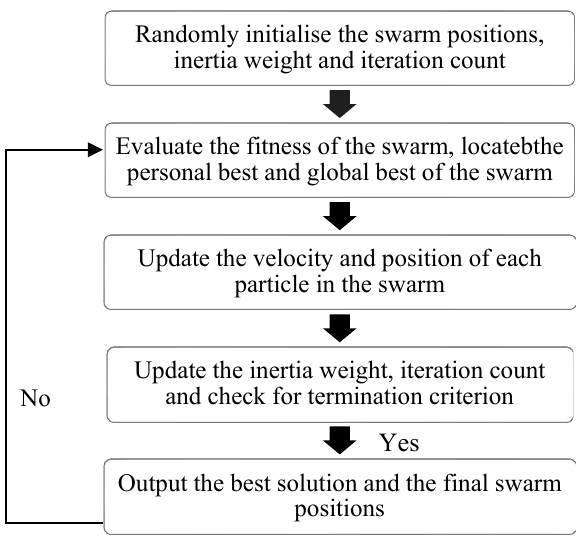
Randomly initialise the swarm positions, inertia weight and iteration